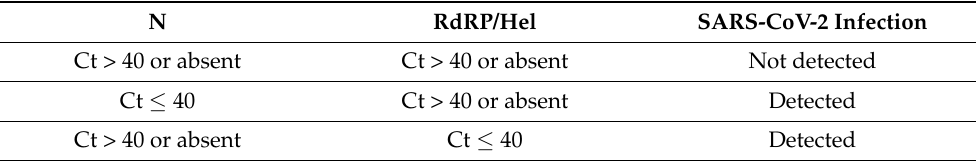
Table 1. Scheme for the diagnosis of SARS-CoV-2 positivitiy by RT-qPCR. N RdRP/Hel SARS-CoV-2 Infection Ct > 40 or absent Ct > 40 or absent Not detected Ct ≤ 40 Ct > 40 or absent Detected Ct > 40 or absent Ct ≤